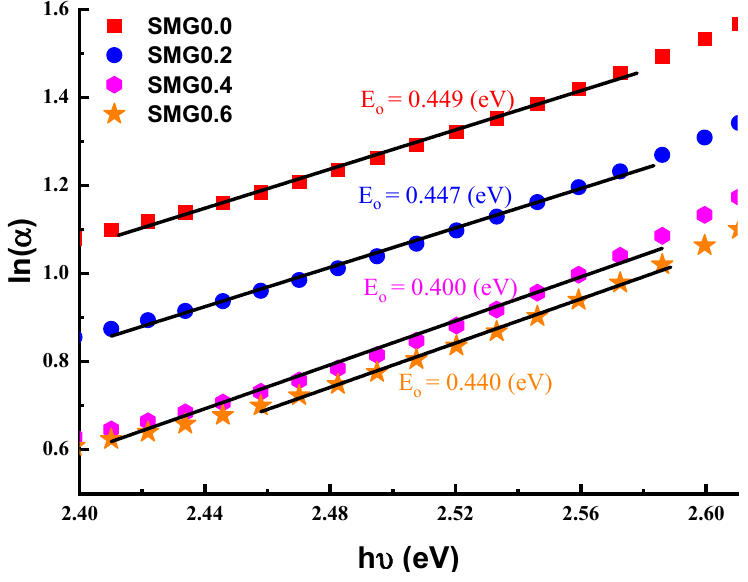
Figure 8. ln( α ) of glass samples vs. the incident photon energy.